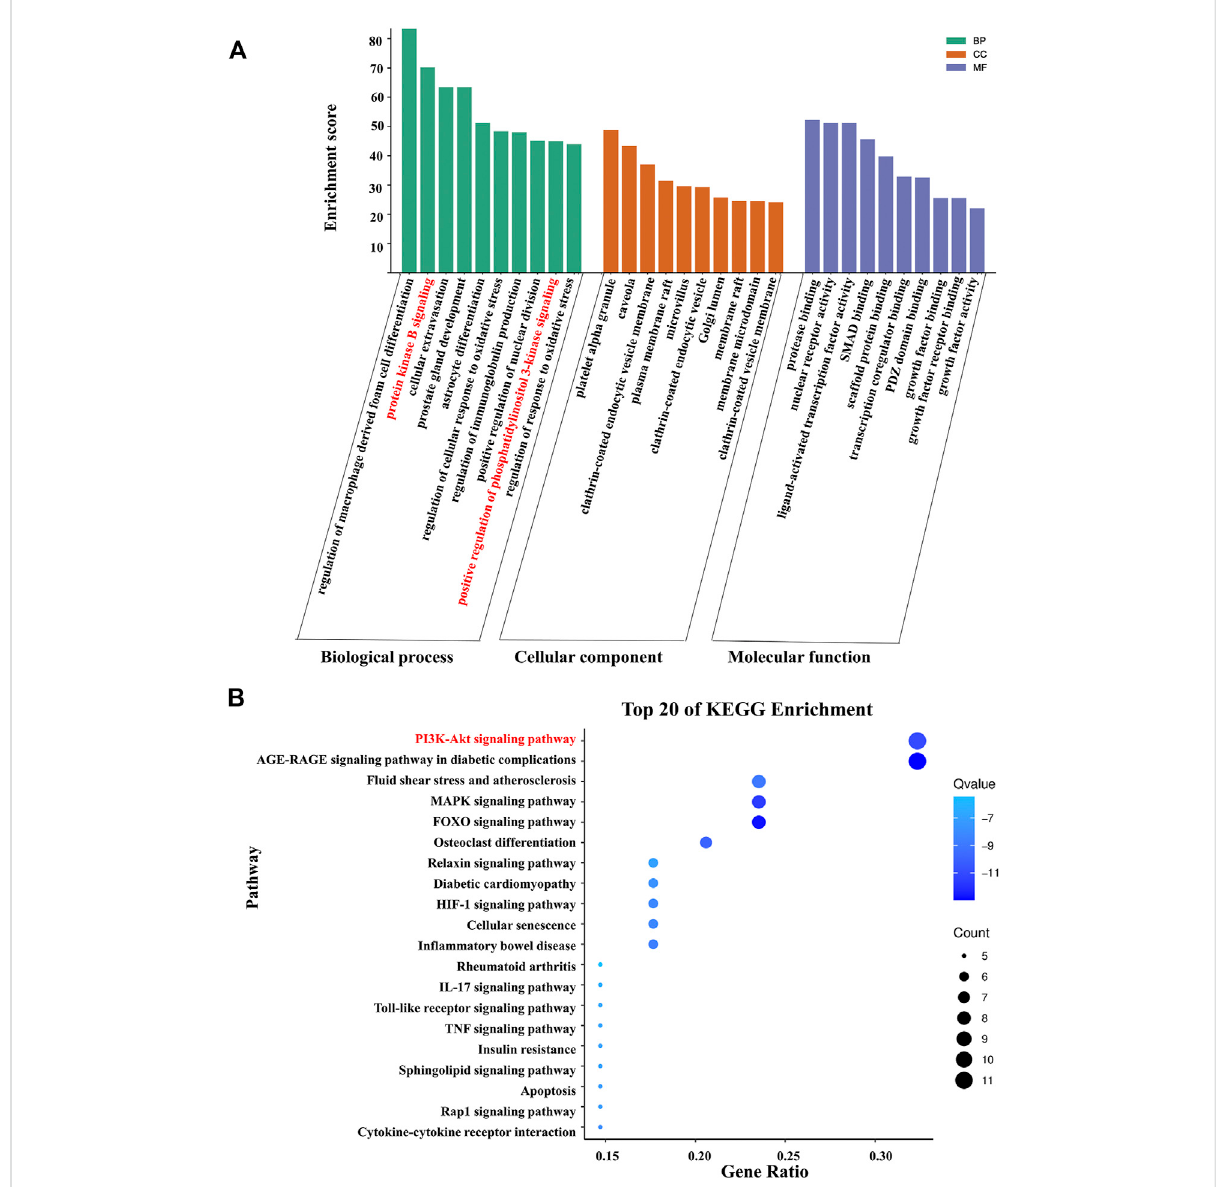
FIGURE 5 KEGG pathway enrichment analysis and GO functional enrichment analysis of Cordyceps in treating tachyarrhythmia. (A) GO functional analysis.Thetop10itemsofeachpartareshown. (B) KEGGpathwayenrichmentanalysis.Thesizesofthebubblesareillustratedfromlargetosmallin descending order of the number of potential targets involved in the